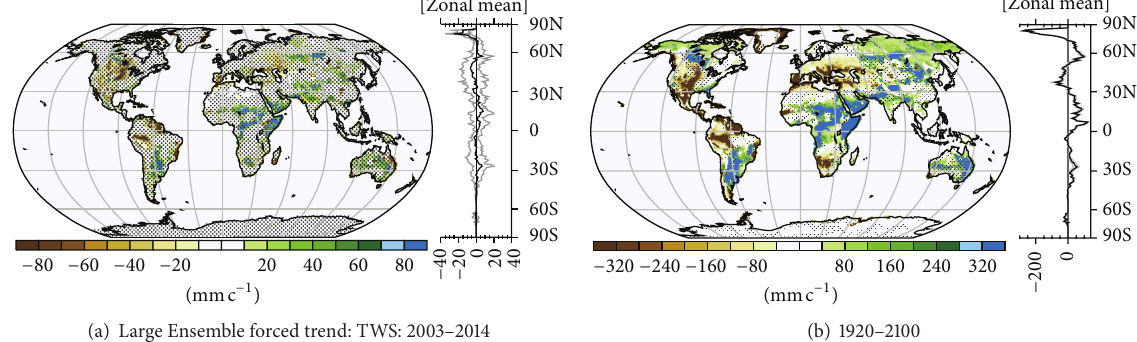
Figure 4: CESM forced trends in TWS from (a) 2003–2014 and (b) 1920–2100. Regions in which the ensemble mean trend is less than the standard deviation among ensemble members are stippled.